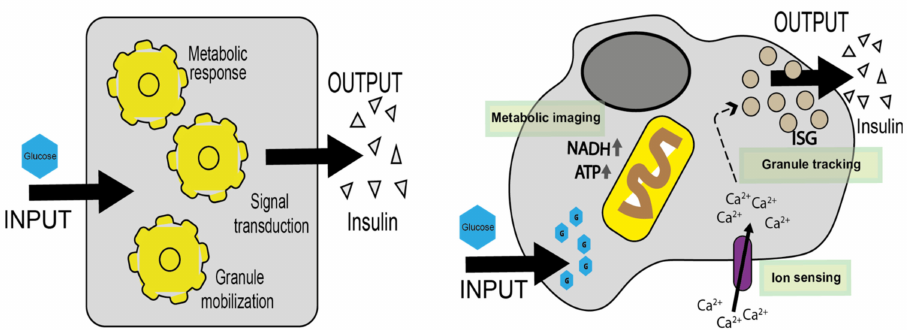
Figure 1. The β -cell as a black box. Main functions (metabolic response, signal transduction and granule mobilization) of the β -cell that link glucose stimulation (input) to insulin secretion (output) are reported as ‘black boxes’ in the image on the left. In detail, on the right, are the most important molecular players that exert these functions. Labelled in green are three microscopy optical tools compatible with living matter and capable of monitoring these functions in real time. ISG, insulin secretory